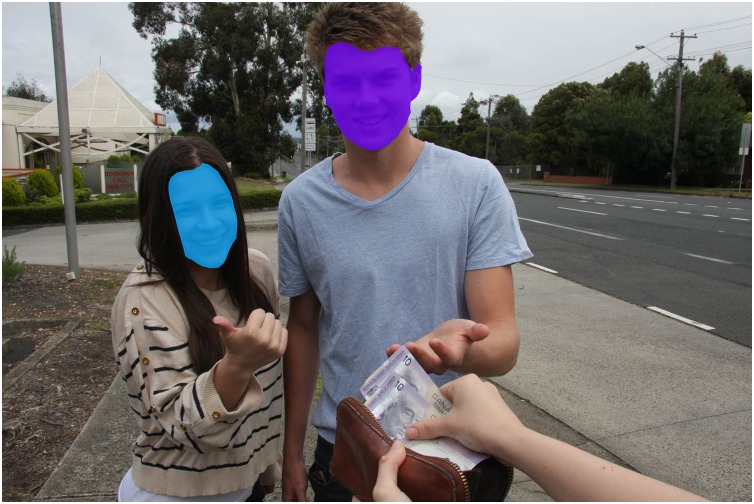
Example of selected regions of interest (ROIs).